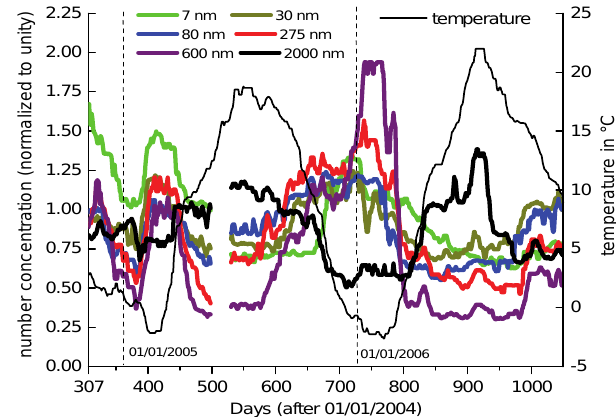
Fig. 3. Median number and volume size distributions of ambient (TDMPS/APS) and non-volatile (TDMPS with TD) particle con- centrations in Augsburg between November 2004 and November 2006. Volume size distributions were calculated assuming spheri- cal particles. Dashed lines mark the location of the two particles modes in the non-volatile distribution.